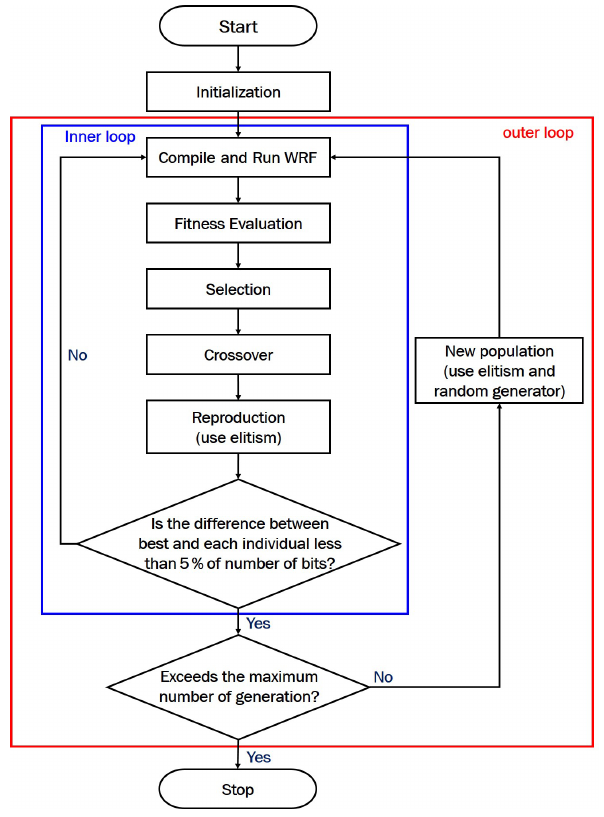
Table 1. A 2 × 2 contingency table.